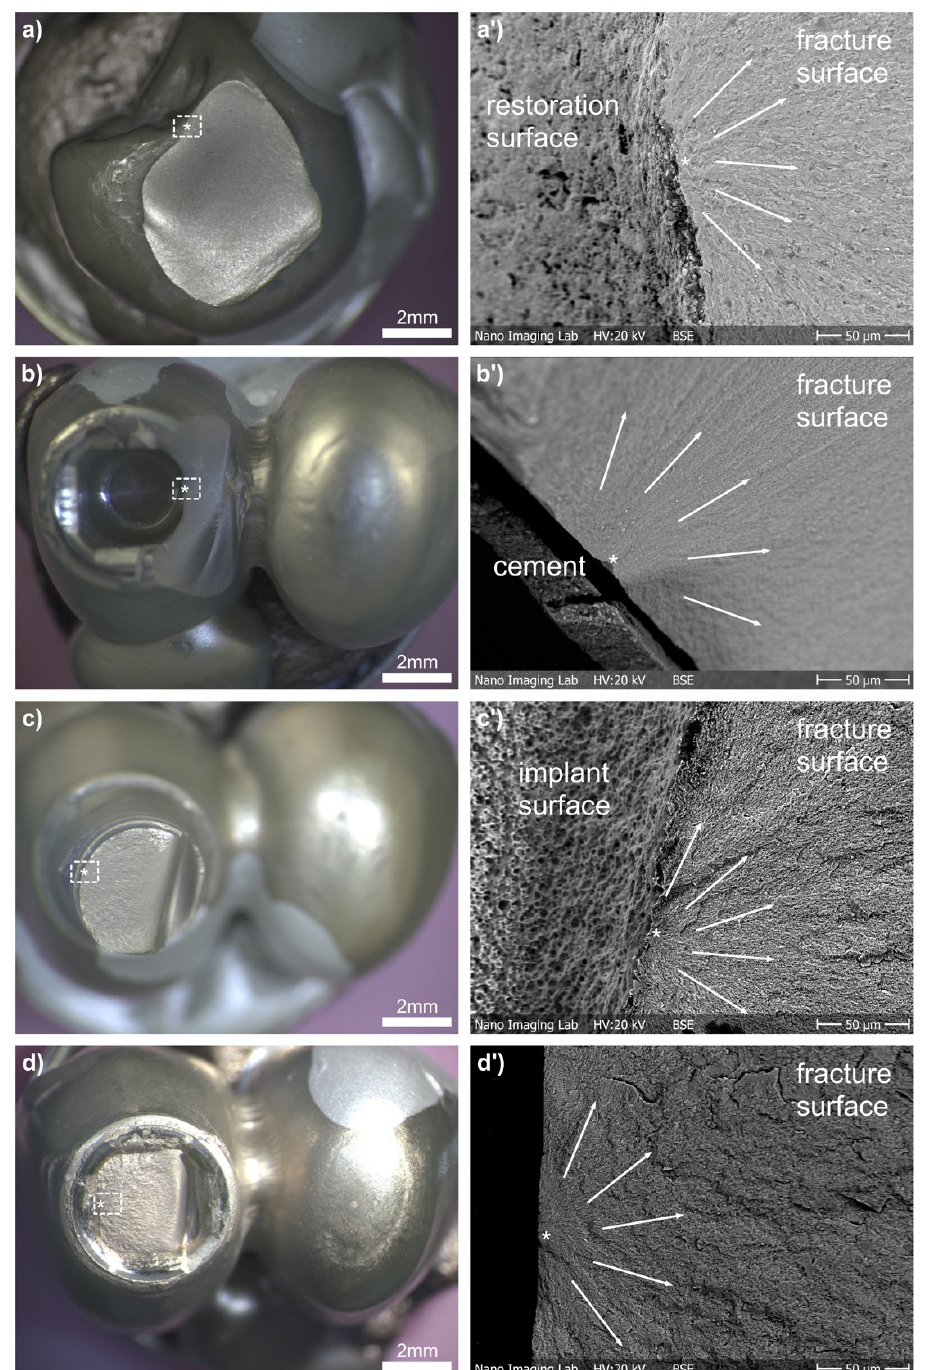
Figure 4. Analysis of fracture origin (*) in light microscopy and scanning electron microscopy (’) images for the different failures of Type 1 ( a ) connector, and ( b ) crown margin; and Type 2 ( c ) implant embedding height, and ( d ) implant abutment height.